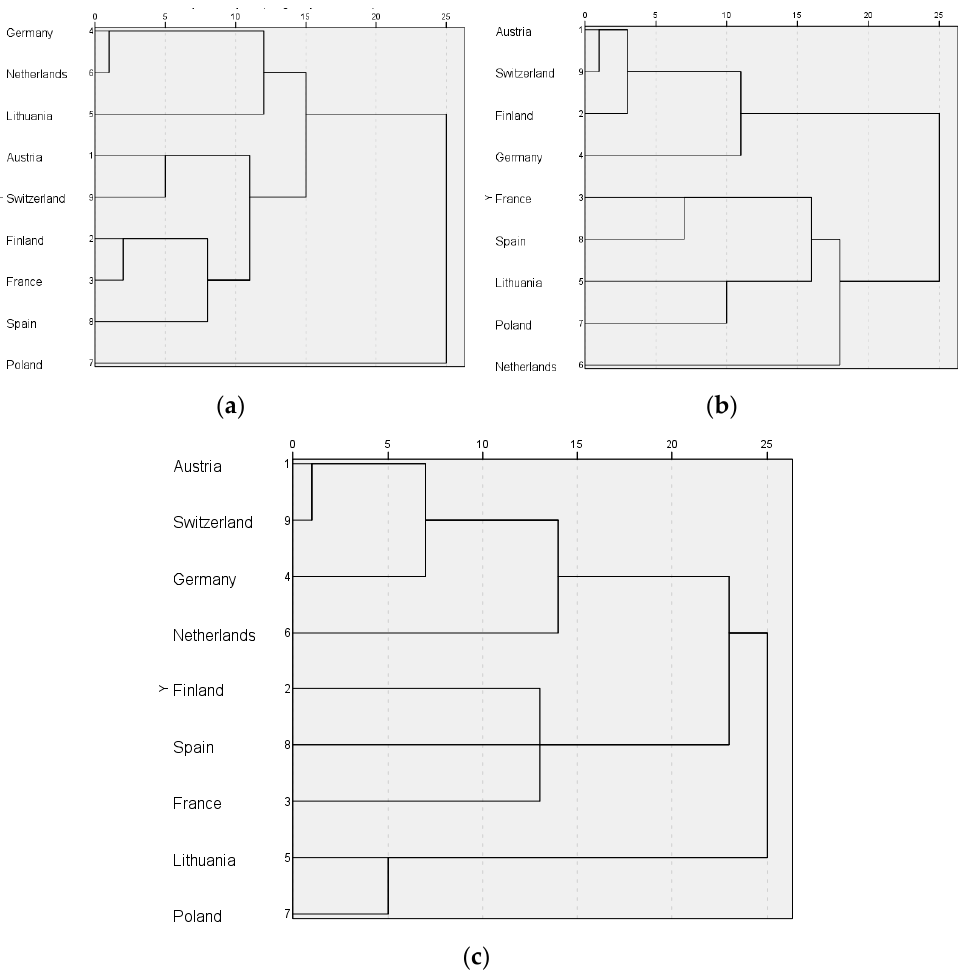
Figure 3. Similarity among policy mixes in terms of: ( a ) policy aims, ( b ) sectors, ( c ) instrument types.